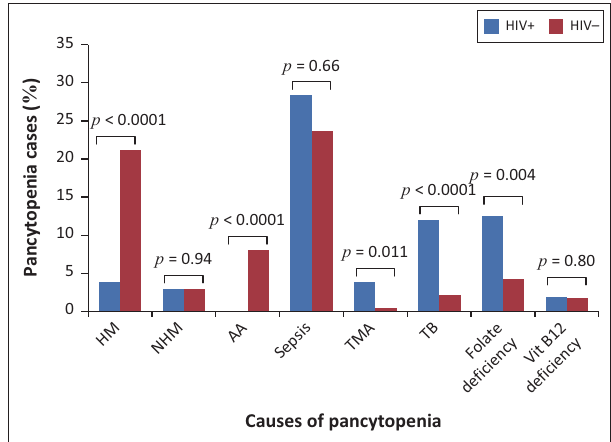
FIGURE 4: Proportions of various causes of pancytopenia among HIV-positive and HIV-negative patients at Tygerberg Academic Hospital, Cape Town, South Africa, from January 2016 to December 2017. HM, haematological malignancy; NHM, non-haematological malignancy; TMA, thrombotic microangiopathy; TB, tuberculosis; Vit, vitamin; AA, aplastic anaemia .